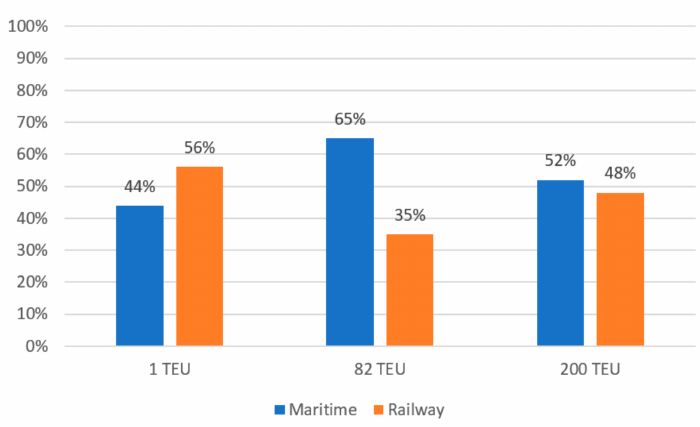
Figure 1. Comparative chart of the results of the